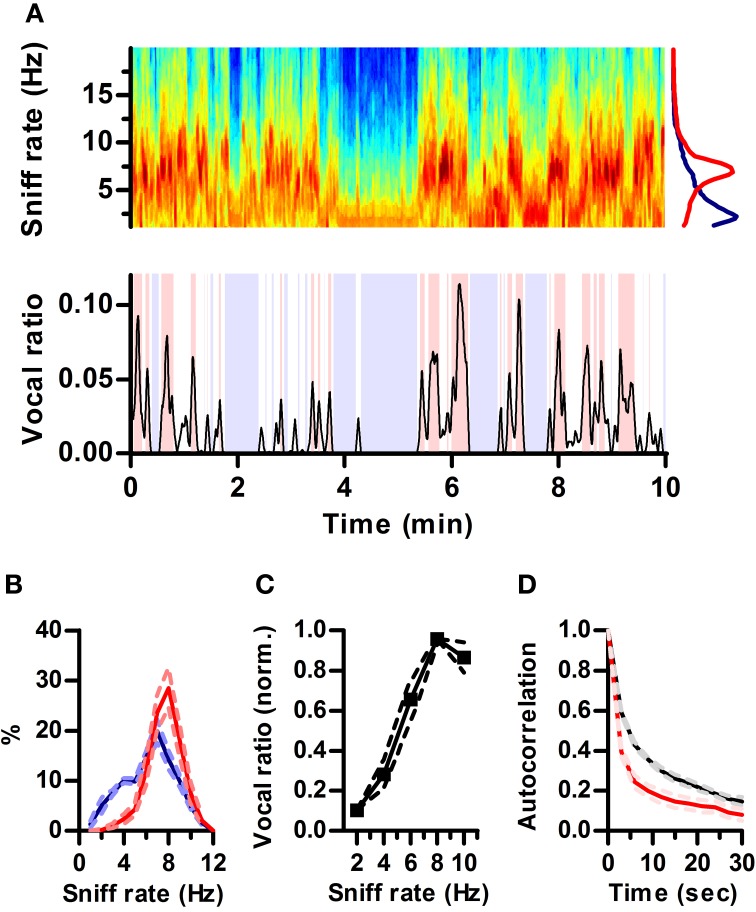
Ultrasonic vocalization occurs during periods of fast sniffing. (A) Top: Spectrogram of a section of the recorded respiration. Warmer tones denote higher power (AU). Note the alternation between periods of fast (~7 Hz) and slow (~2 Hz) respiration. Bottom: simultaneous vocal production from this rat quantified as fraction of time spent vocalizing within a 3 s sliding window (vocal ratio). Blue shading: periods of silence (vocal ratio = 0). Red shading: high vocal production (vocal ratio > 0.025). Top right: mean frequency spectrum of respiration for periods of high vocal production (red; peak = 6.8 Hz) and silence (blue; peak = 2.2 Hz) in the example. (B) Distribution of sniff rates during periods of high vocal production (red) or silence (blue). Mean ± s.e.m., N = 5 rats. (C) Vocal ratio as a function of sniff rate. To account for varying average vocal output of individual rats, curves were normalized by their maximum prior to averaging. Effect of sniff rate on mean vocal ratio: p < 0.0001 (ANOVA, N = 5 rats). (D) Autocorrelations of vocal ratio (red) and sniff rate (black), averaged in 3 s intervals.